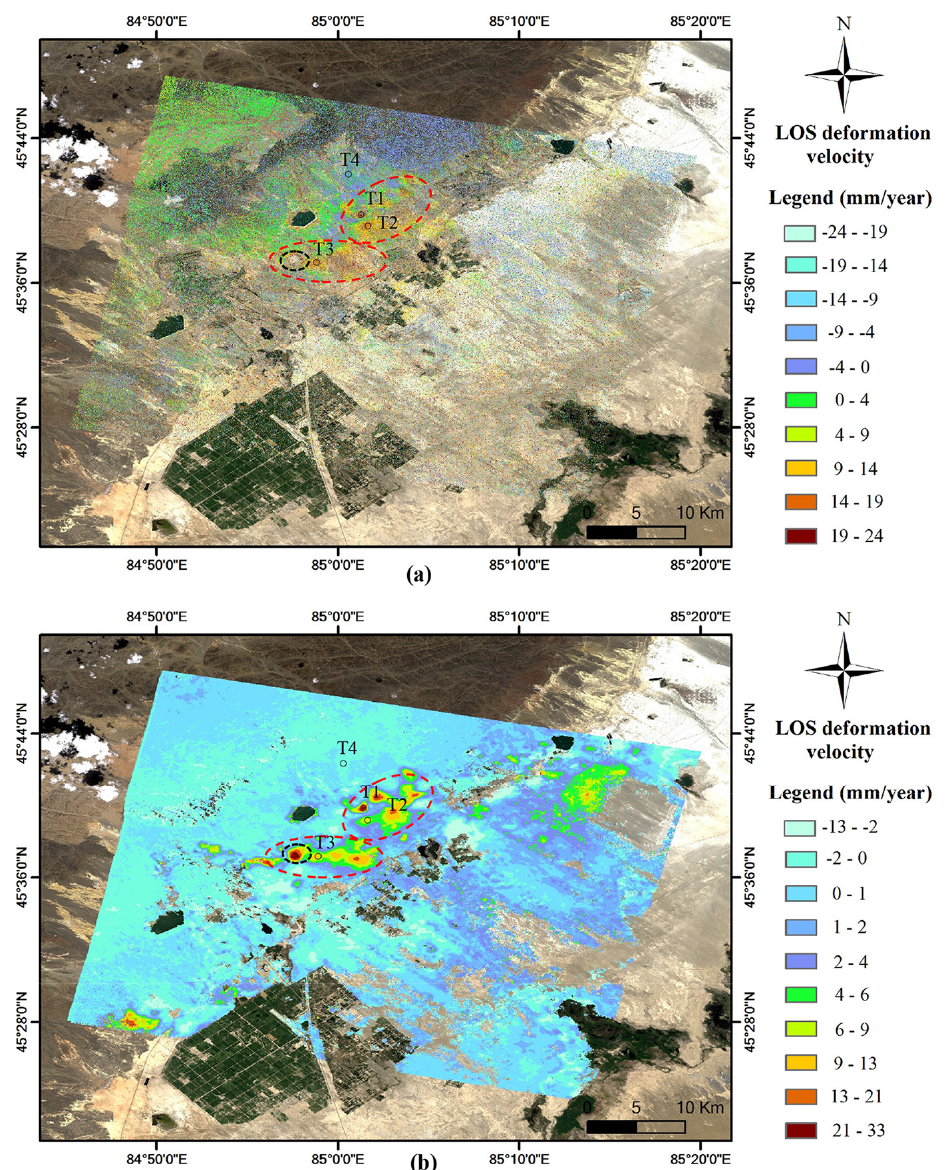
Figure 7. Mean displacement map of ENVISAT ‐ ASAR data from 2003 to 2010. ( a ) The mean displacement velocity map of the PS ‐ InSAR method; ( b ) The mean displacement velocity map of the SBAS ‐ InSAR method. Positive (negative) values indicates the ground close to (away from) the satellite. The points T1, T2, T3 and T4 are chosen for showing the accumulative time series land deformation pattern.